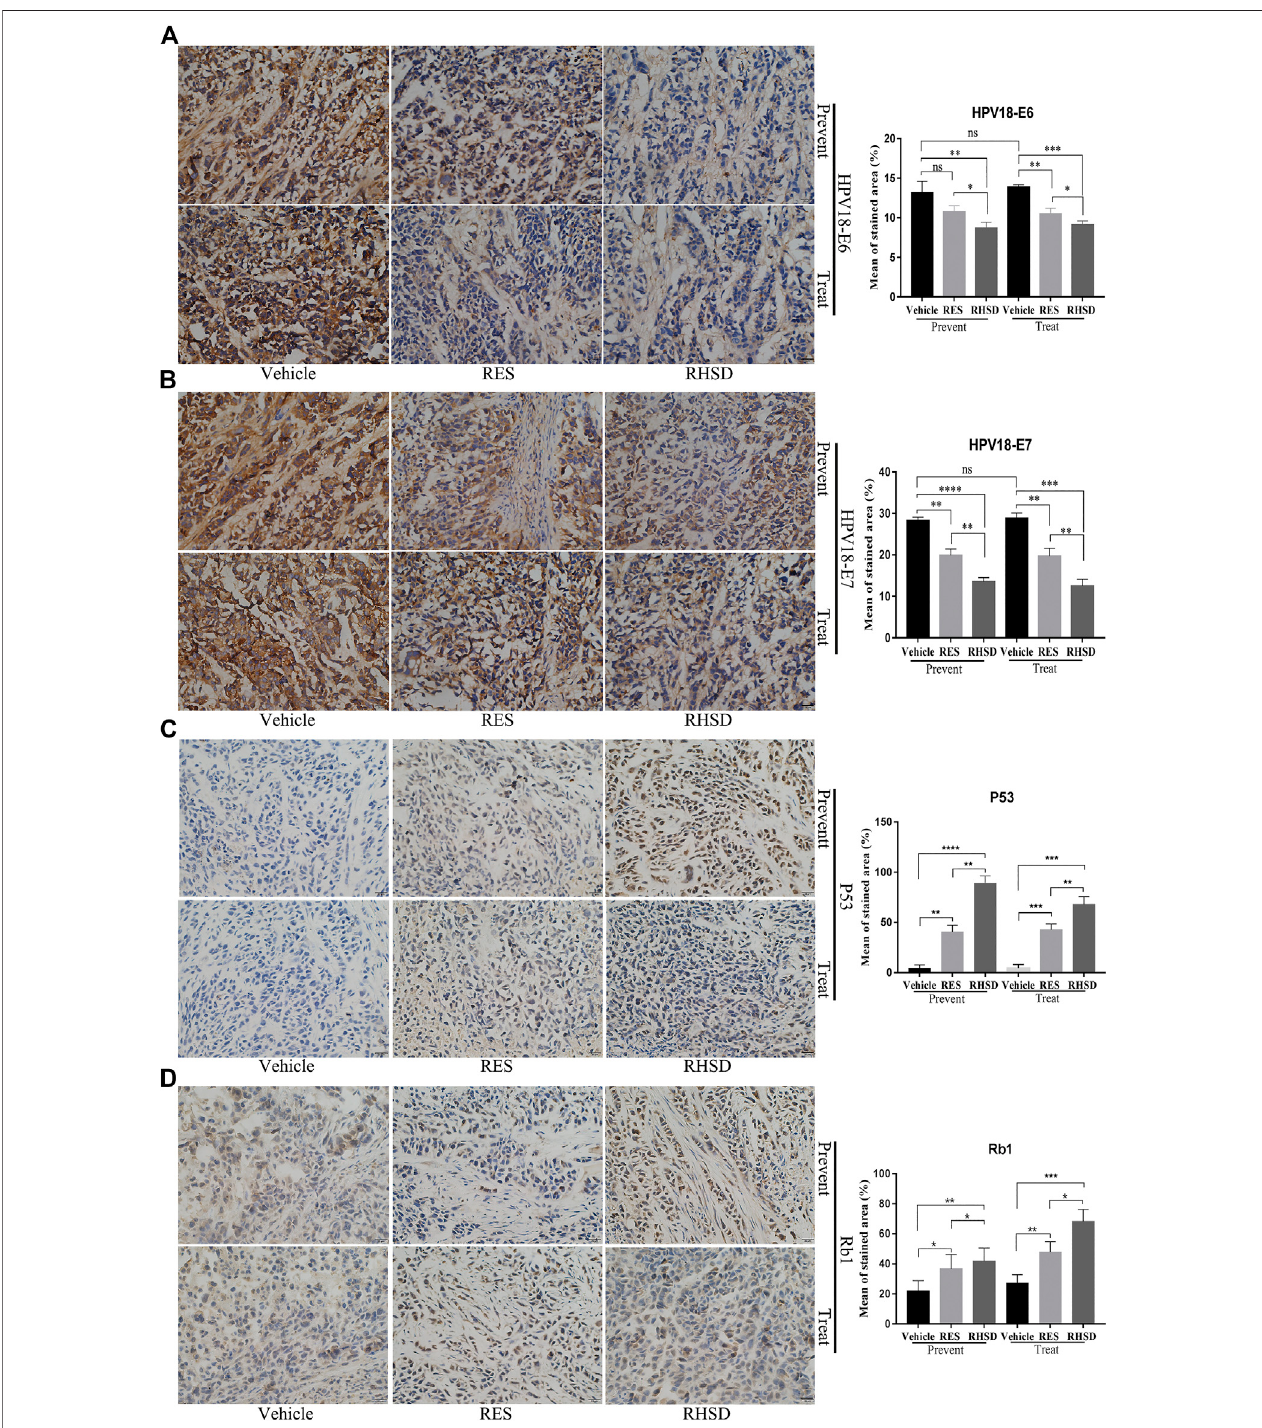
FIGURE 7 | Distribution and expression of HPV18 E6, E7, P53, and Rb1 in cancer tissues. IHC staining of HPV18 E6, E7, P53, and Rb1 protein in tumor samples monoclonal antibody. Tumor sections immunostained with E6 (A) , E7 (B) , P53 (C) , and Rb1 (D) antibodies in mice treated with RES or RHSD (scale bar (cid:1) 20 μ m). The histogram on the right is the quantitative analysis of the results. The data were presented as the mean ± S.D. for three different experiments performed in triplicate. * p < 0.05, ** p < 0.01, *** p < 0.001, **** p < 0.0001.